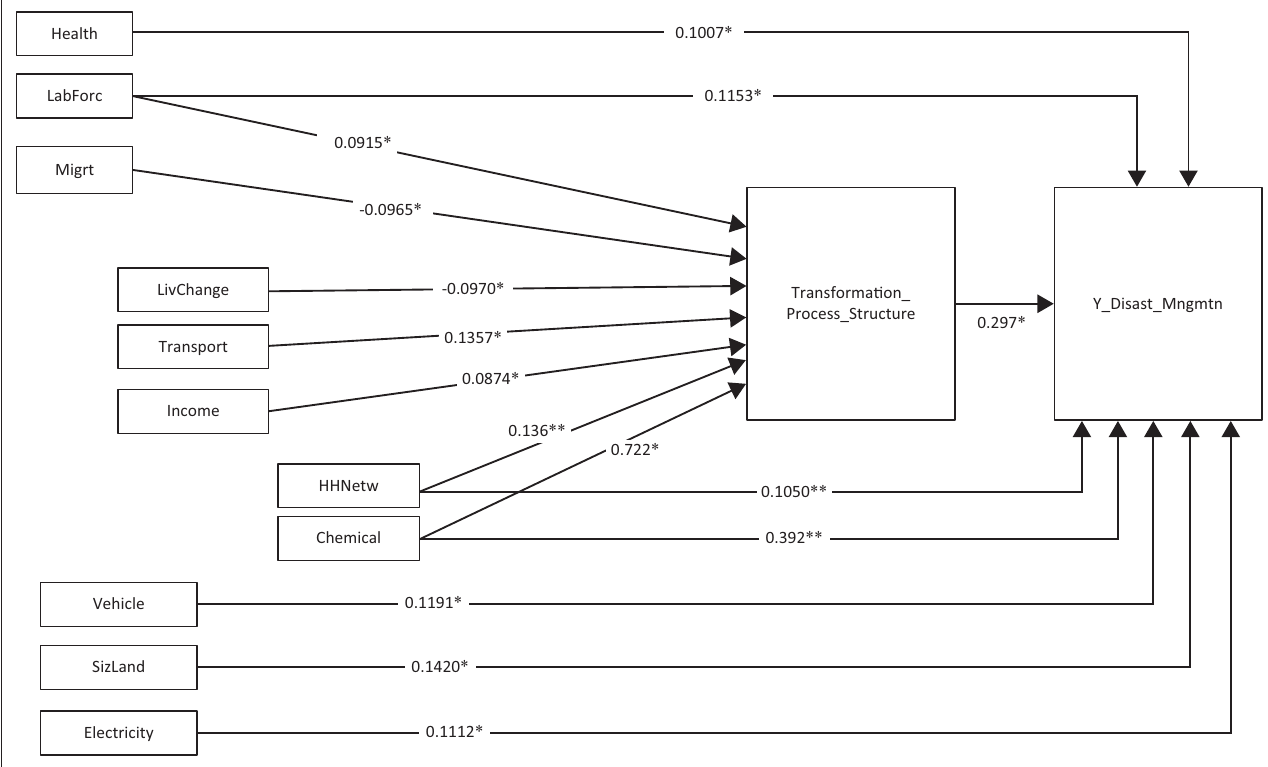
FIGURE 3: Path analysis